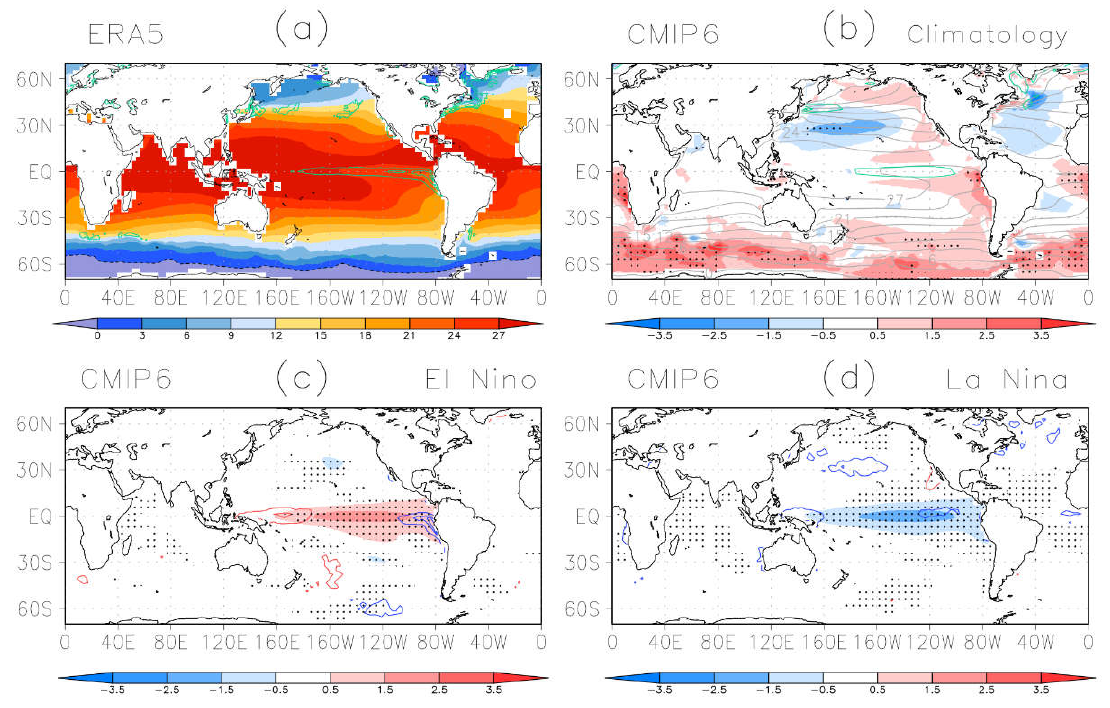
Figure 5. ( a ) Annual mean SST (shaded) and annual variance (contours) from ERA5; ( b ) annual SST (gray contours), annual mean SST bias (shaded), and annual variance (aqua contours) from CMIP6 multi-model ensemble; composite SST anomaly (shaded) and SST bias (contour) during ( c ) El Niño and ( d ) La Niña, where positive (negative) anomalies of Niño-3.4 SST greater (smaller) than 1.0 °C (−1.0 °C) are selected to construct composites of warm (cold) events. Stippling indicates where the anomaly of all models has the same sign.